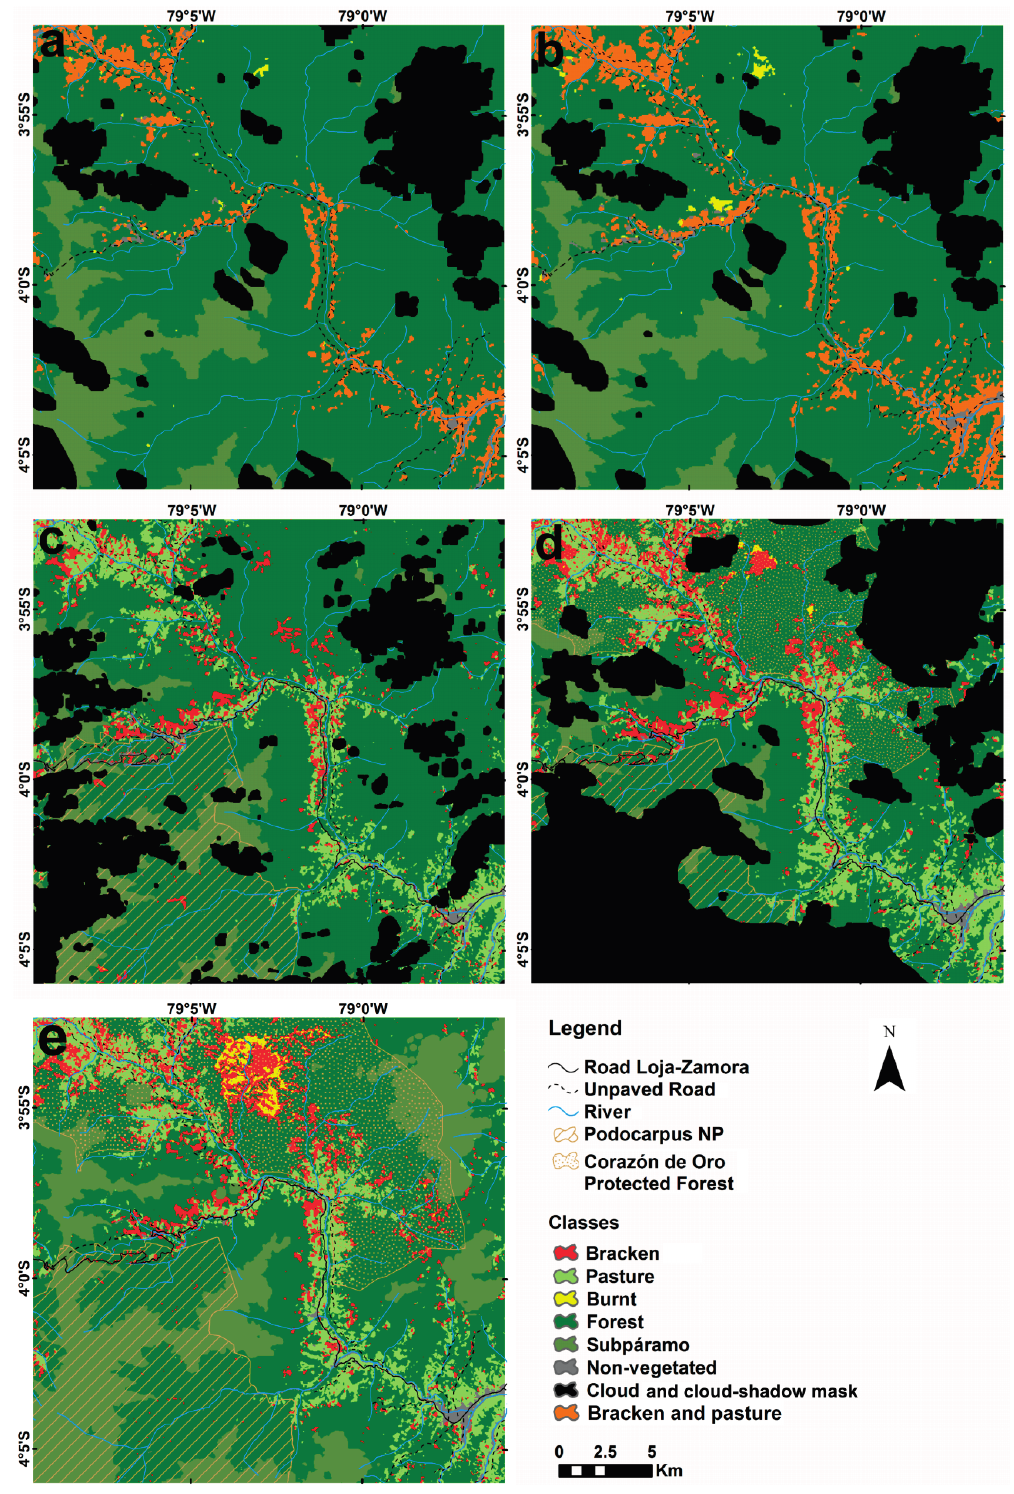
Figure 7. Classification results of the satellite images from the following years: ( a ) 1975; ( b ) 1980; ( c ) 1987; ( d ) 2000; and ( e )